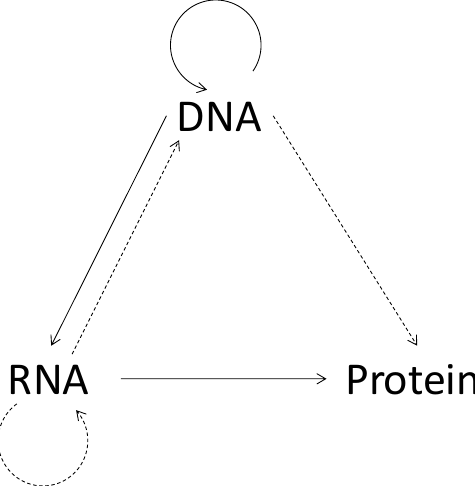
Figure 5. The central dogma of molecular biology [31].